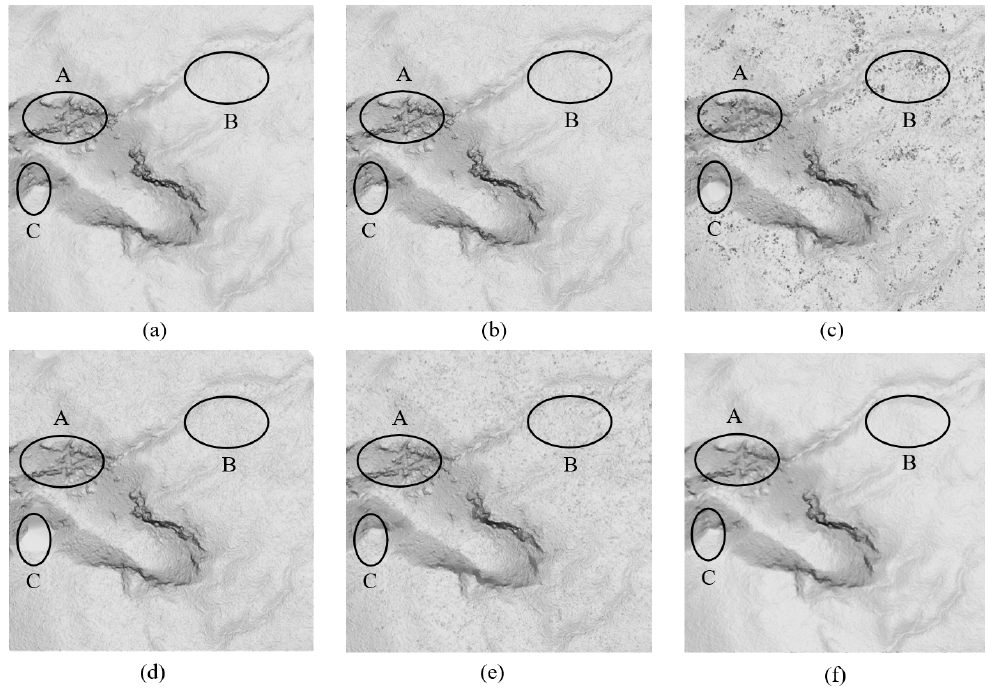
Figure 13. DTMs of ( a ) reference, ( b ) PPDF, ( c ) MSF, ( d ) PMF, ( e ) CSF, and ( f ) PTDF in Site 2. MSF, PMF, CSF, and PTDF represent the four comparative methods, i.e., maximum slope filtering, progressive morphology filtering, cloth simulation filtering, and progressive triangular irregular network densification filtering methods.